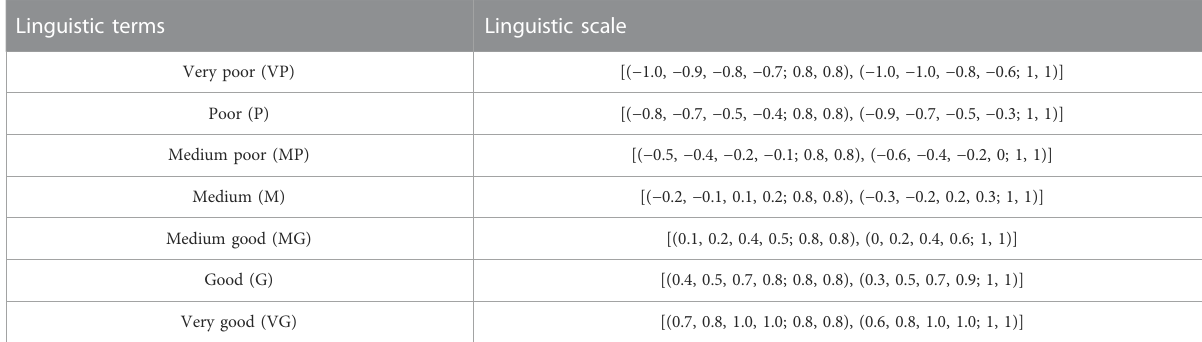
TABLE 1 Linguistic scale of restriction for the extended IT2FVIKOR. Linguistic terms